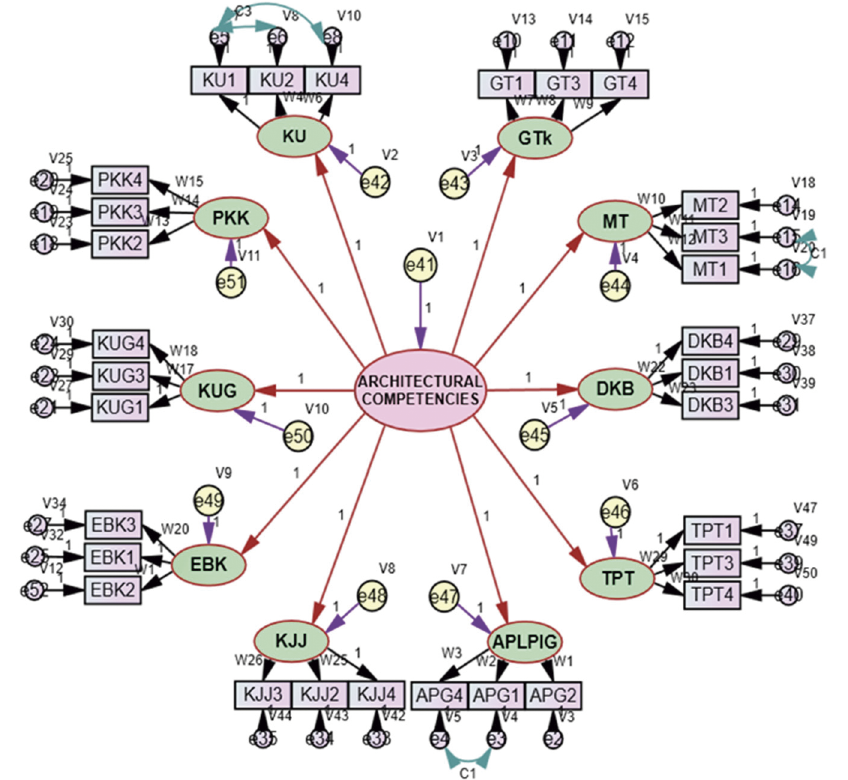
Figure 2. Second-order model for measuring student competency achievement